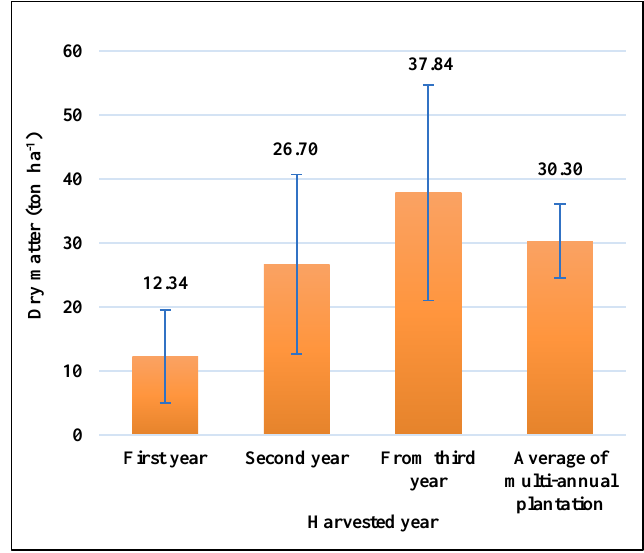
Figure 2. Chemical composition of different segments of giant reed Source: Neto et al. (1997); Shatalov & Pereira (2002a,b); Ververis et al. (2004)